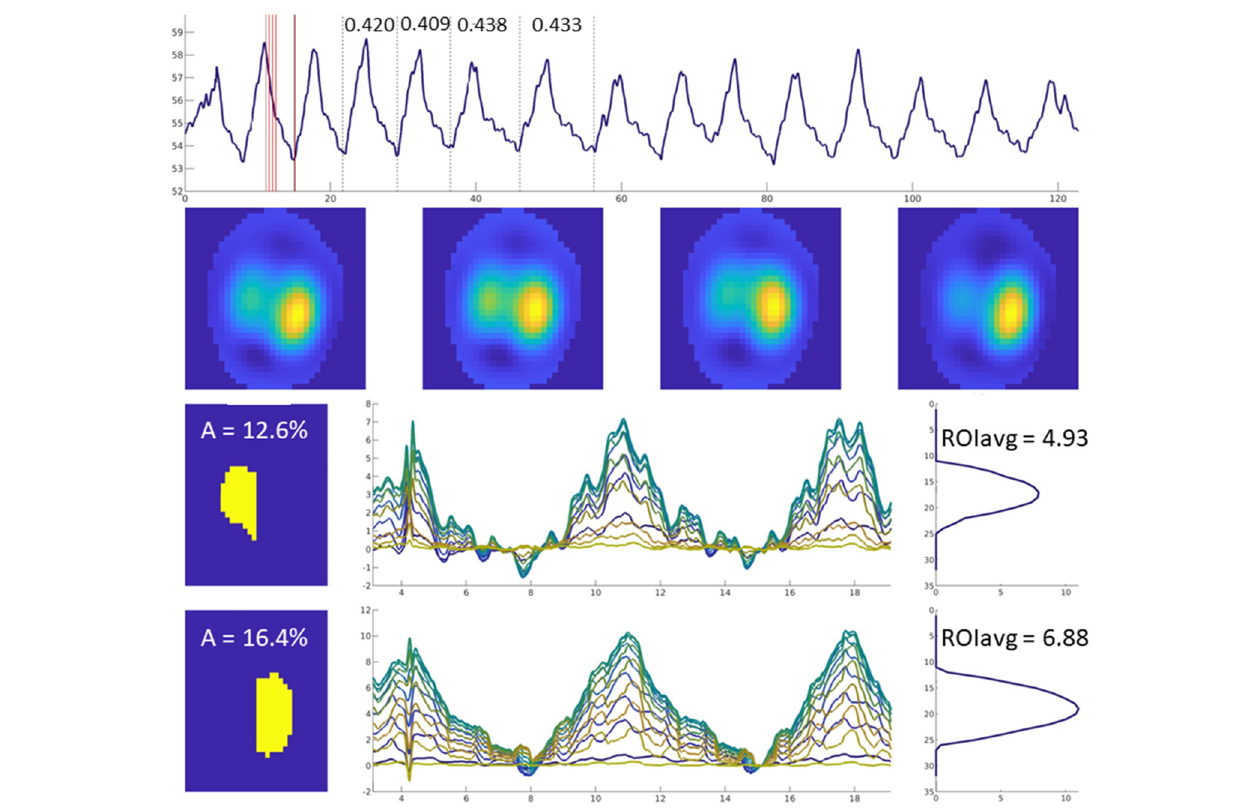
FIGURE 13 | Images of four breaths are displayed in the upper horizontal row. The mean ventilated area is shown in the left-sided column in yellow (left lung top, right lung bottom image). Impedance change over time is graphically illustrated for each of the 32 lines in different colours.